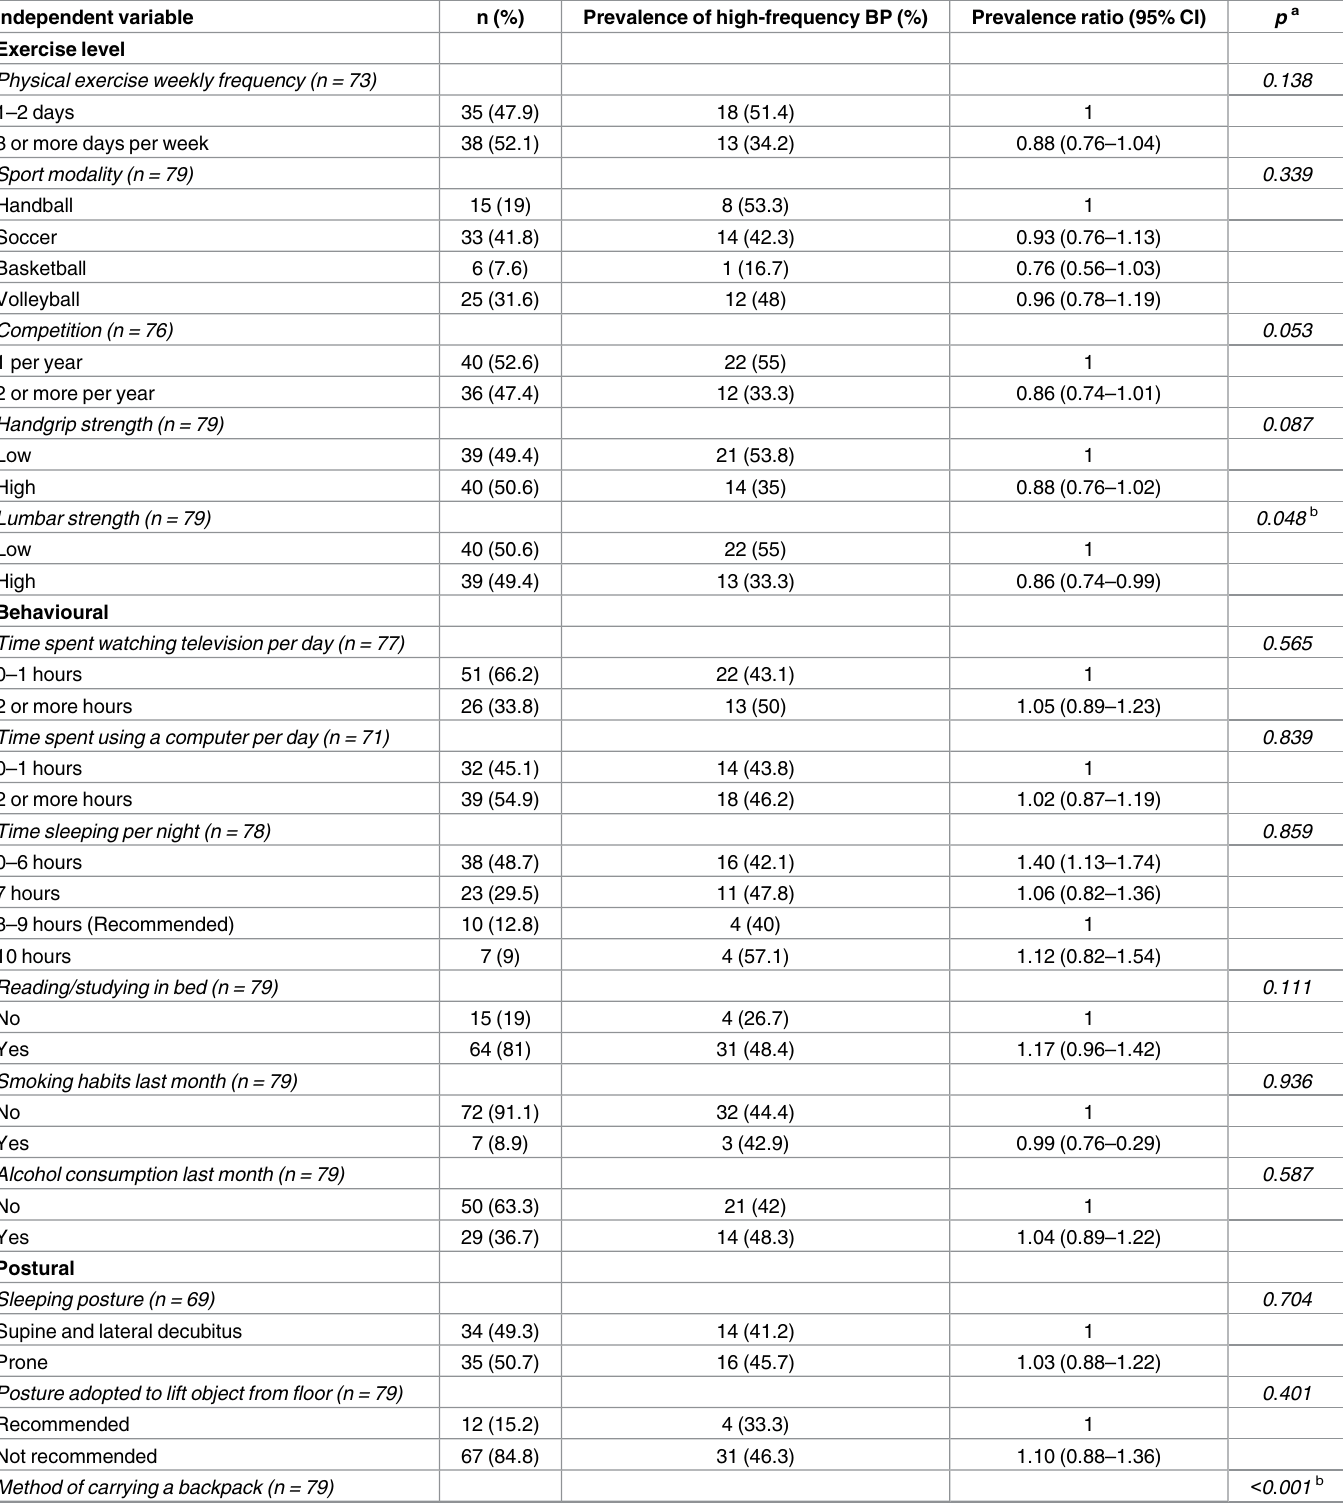
Table 5. Association ( χ 2 ) and prevalence ratio of back pain frequency with independent variables (exerciselevel, behavioural, and